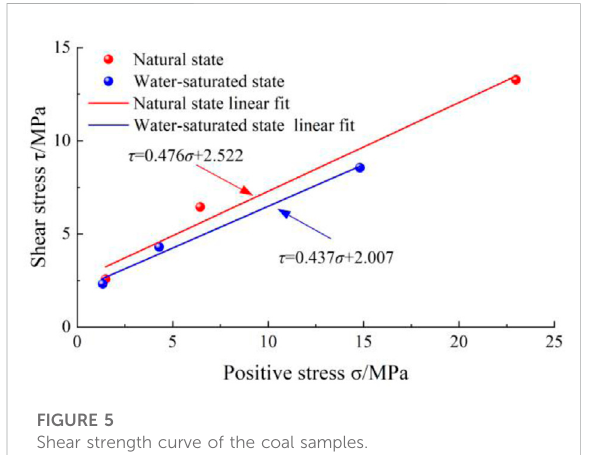
FIGURE 5 Shear strength curve of the coal